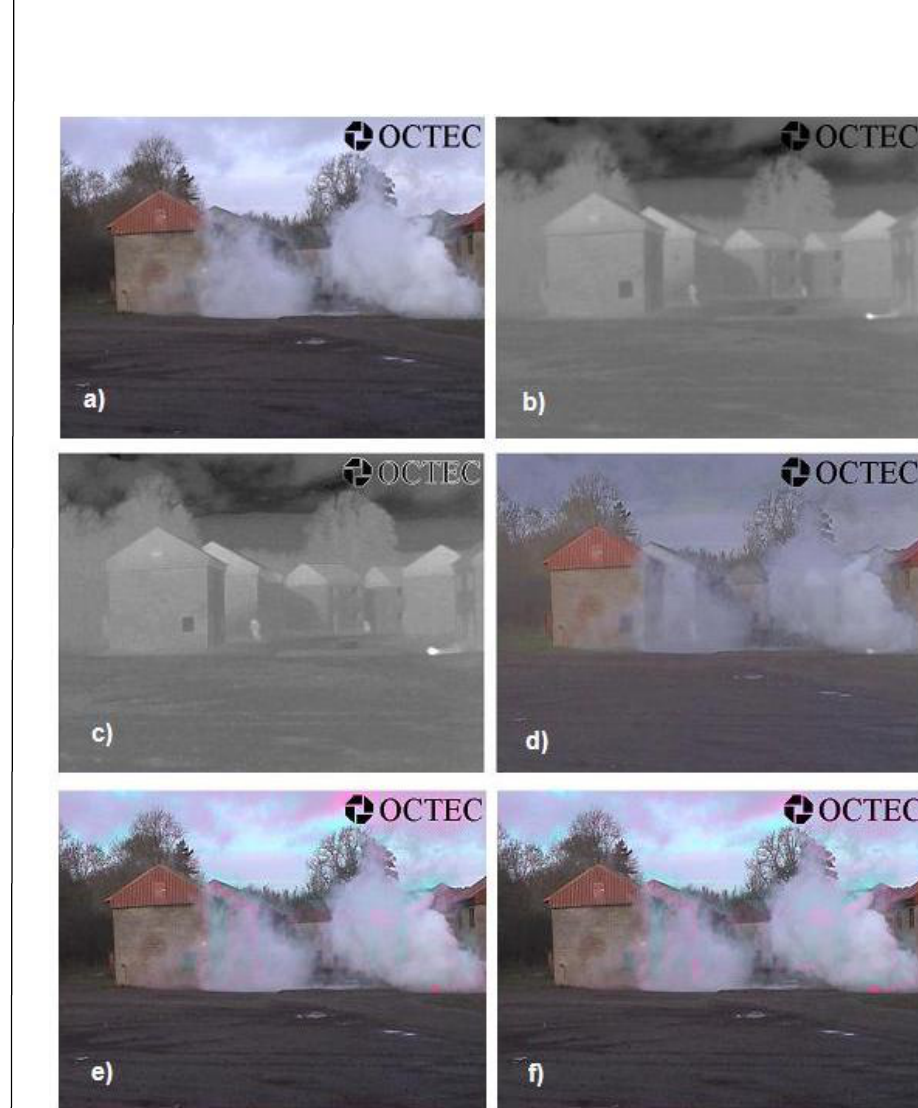
Figure 13 – Input images and images fused with color fusion: a) and b) true color and IR inputs of the OCTEC dataset, c) enhanced IR image I’, d) HSV fusion result, e) and f) images fused using the l αβ method without and with structural